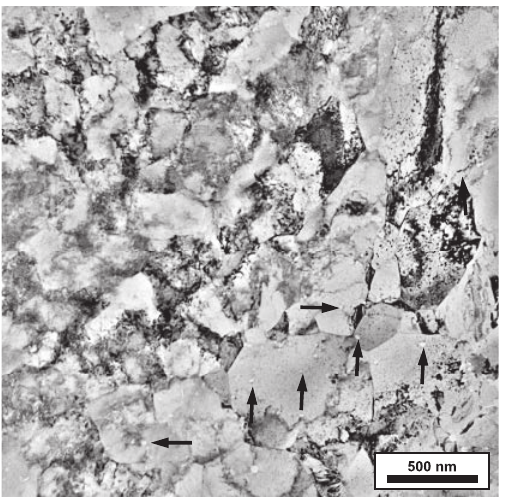
Fig. 3: Coefficient of friction of all experimental materials as function of